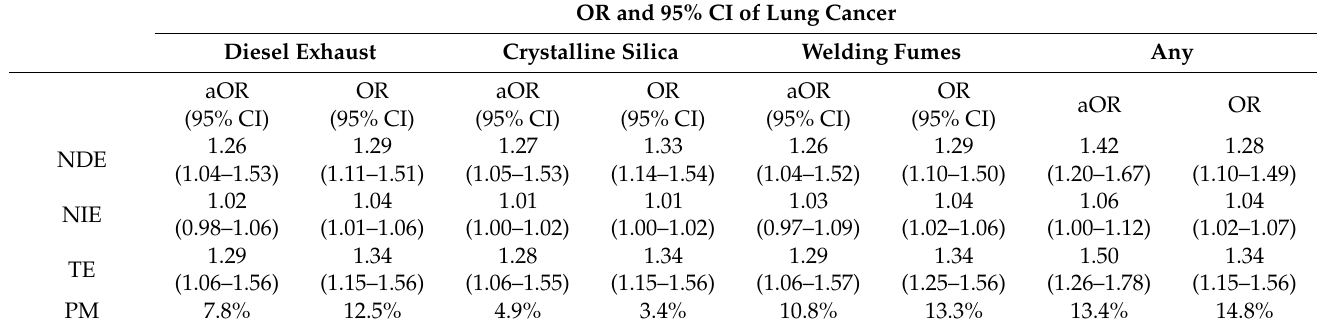
Table 4. Analysis of the mediating effect of selected occupational carcinogens on the association between education and lung cancer. OR and 95% CI of Lung